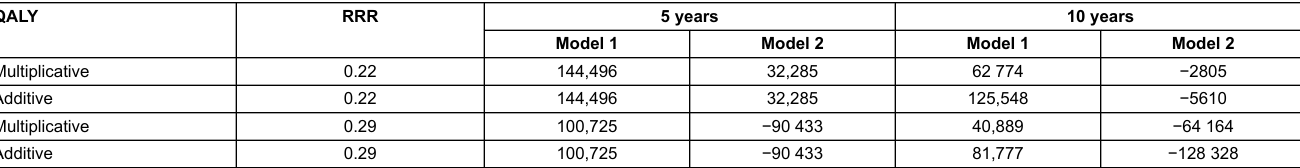
Table 6: Cost per QALY (ICER) using a 16 model sensitivity analysis. QALY